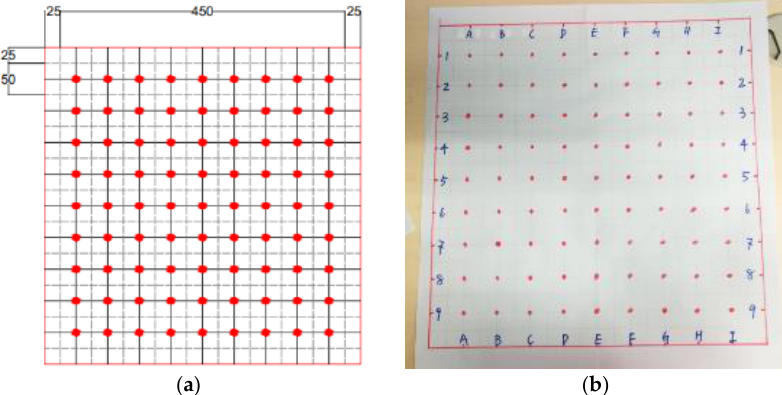
Figure 6. Testing area divisions of the UHPFRC plate. ( a ) Schematic graph (unit: mm) and ( b ) practical experimental design.